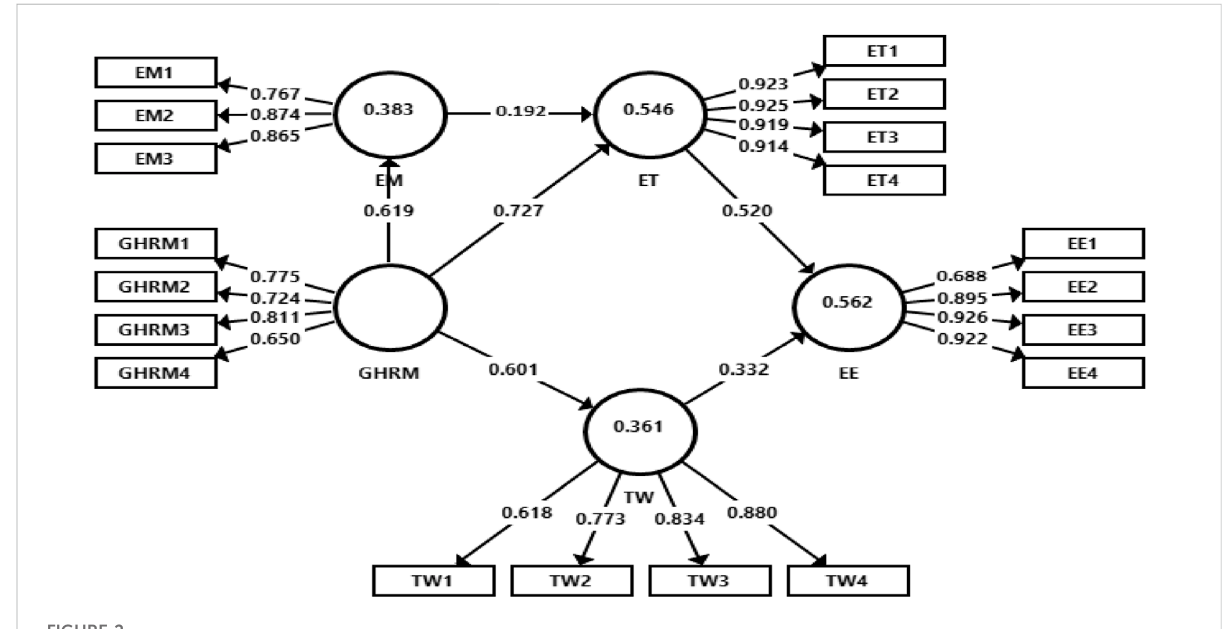
FIGURE 2 PLS measurement